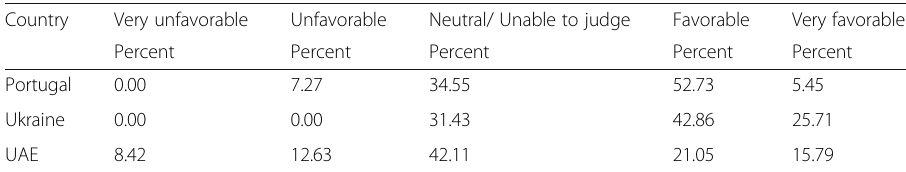
Table 2 Attitudes toward distance education Country Very unfavorable Unfavorable Neutral/ Unable to judge Favorable Very favorable